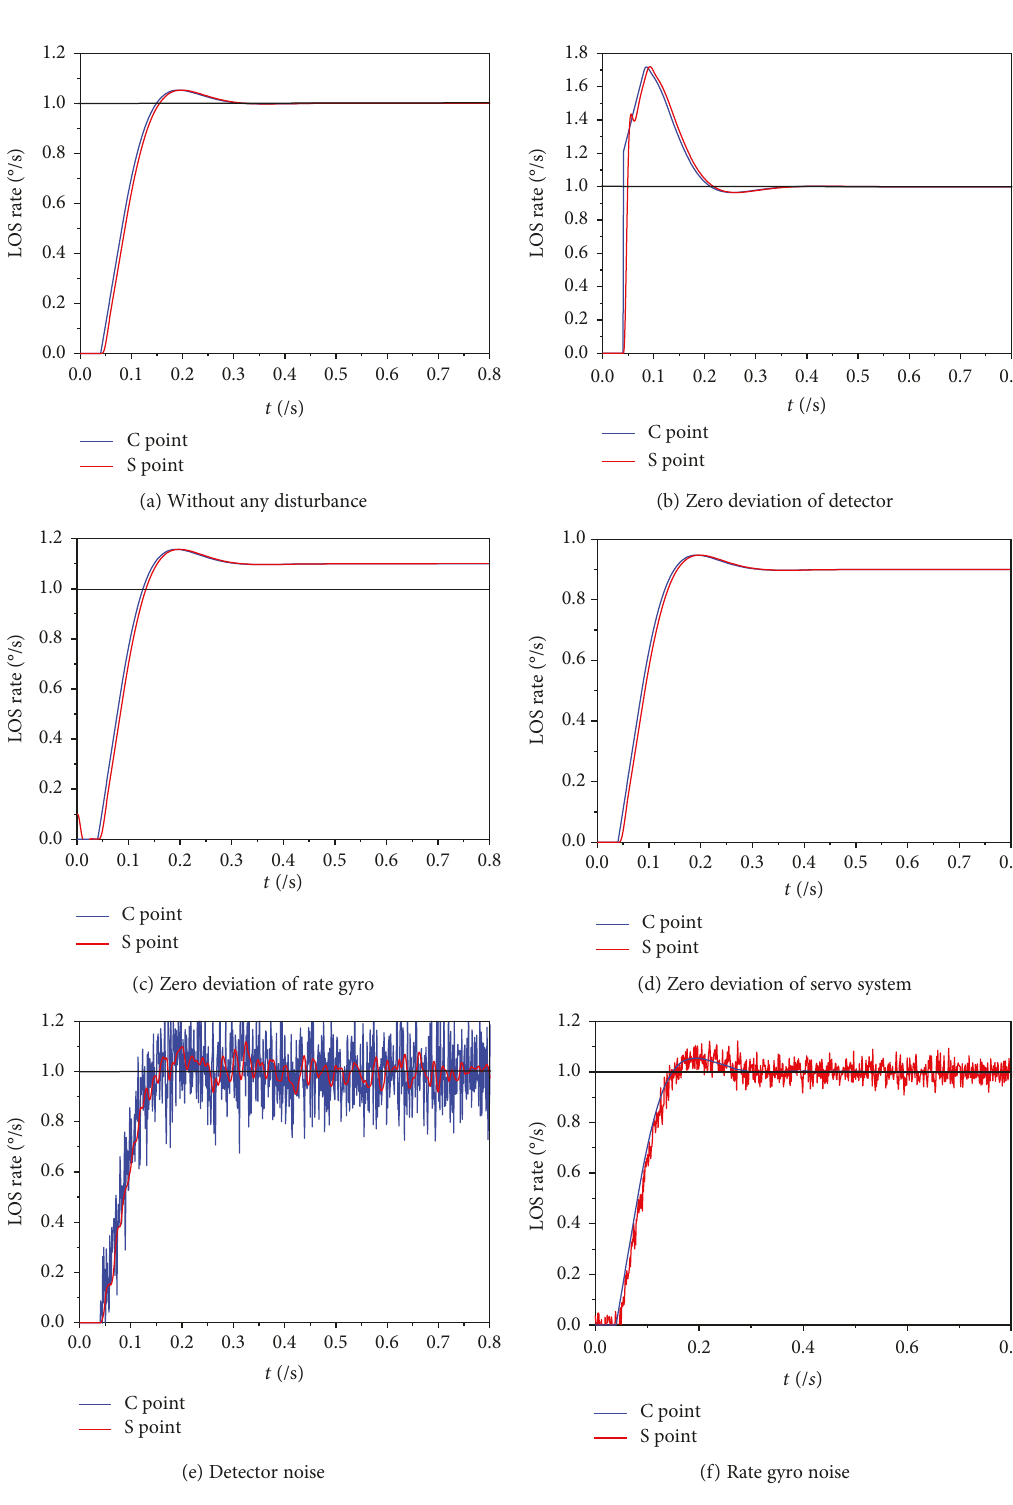
Figure 3: LOS rate extraction from the C point and S